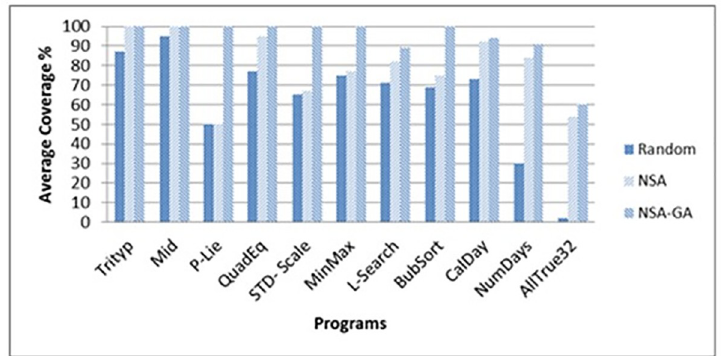
Fig 9. Average coverage percentage for random testing, NSA and NSA-GA methods for all benchmark programs.